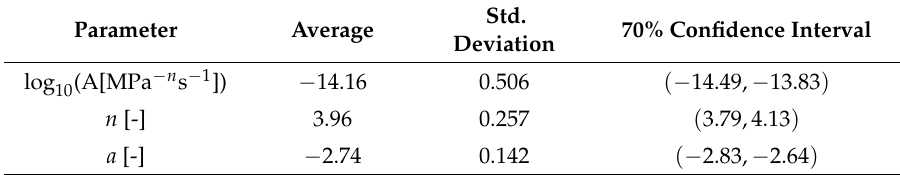
Table 3. Results of the inverse identification—Compression creep—Reduced number of